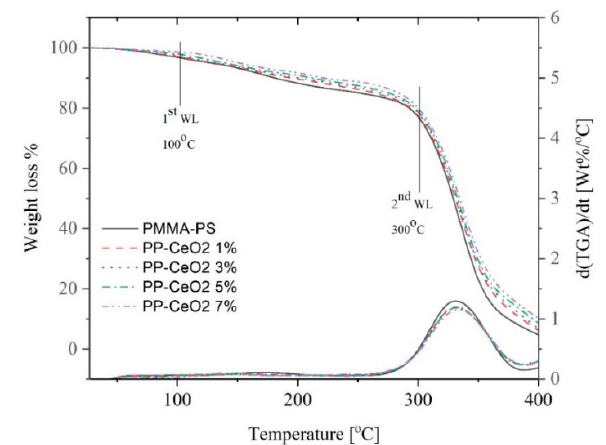
Figure 9. The weight loss and 1st derivative of weight loss of PMMA-PS incorporated with differ- ent concentrations of CeO 2 NPs as a function of temperature.